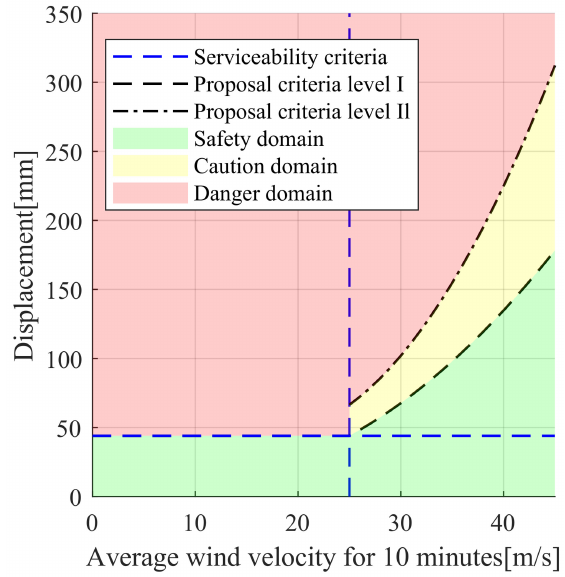
Figure 11. Proposed reference values for bu ff eting